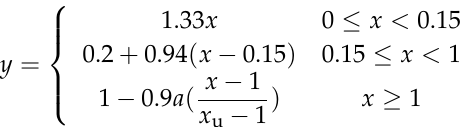
Figure 14. The dimensionless stress–strain curve and fitted curves.